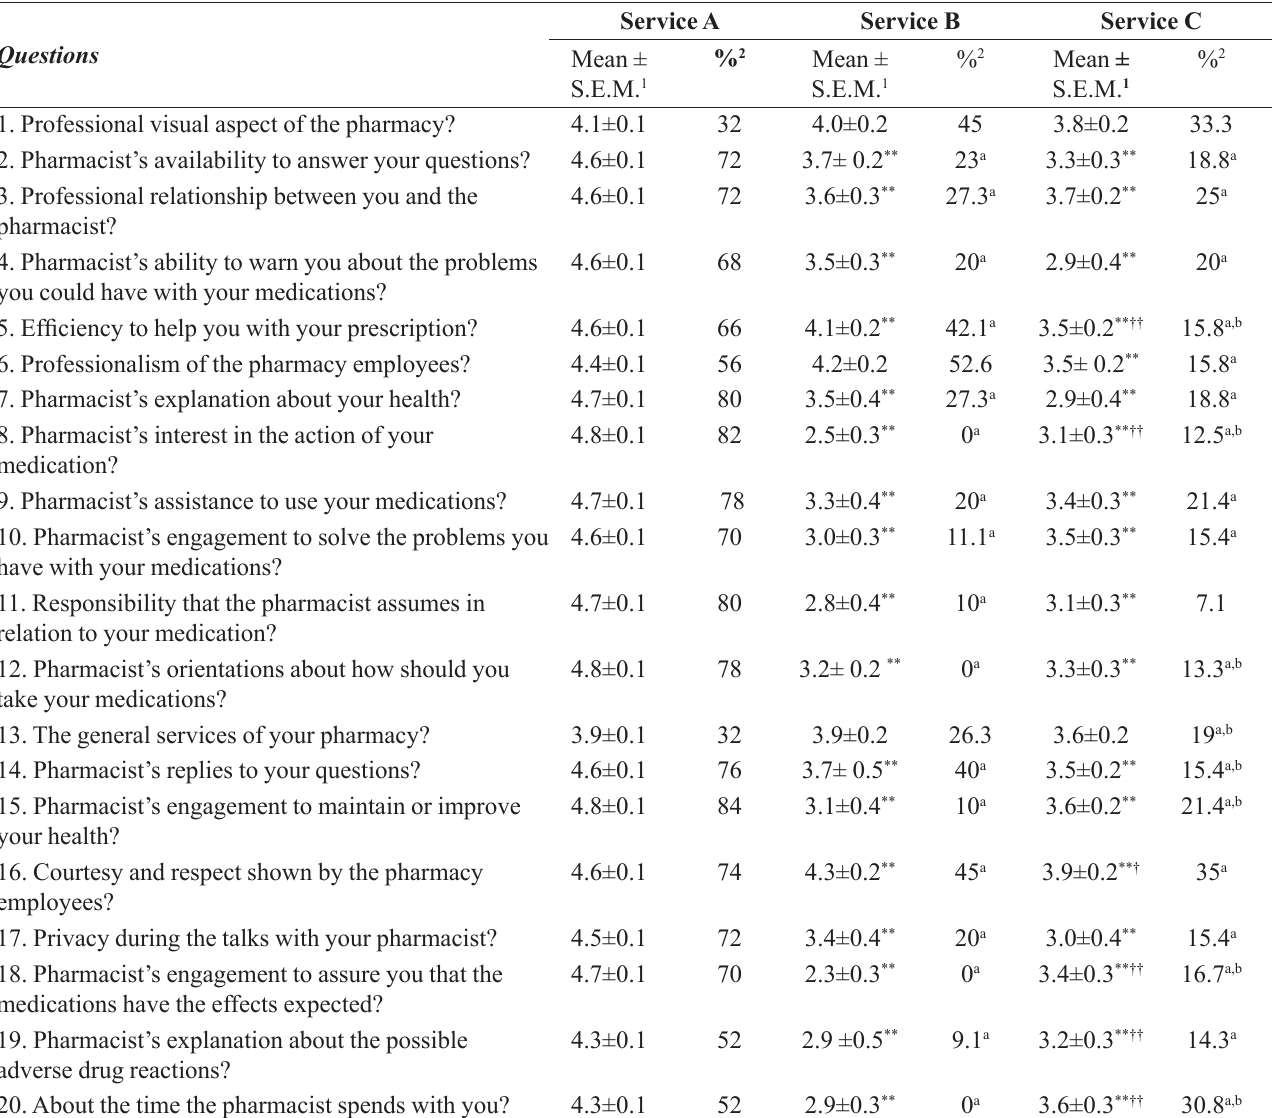
TABLE I – Instrument items of evaluation and replies from the patients